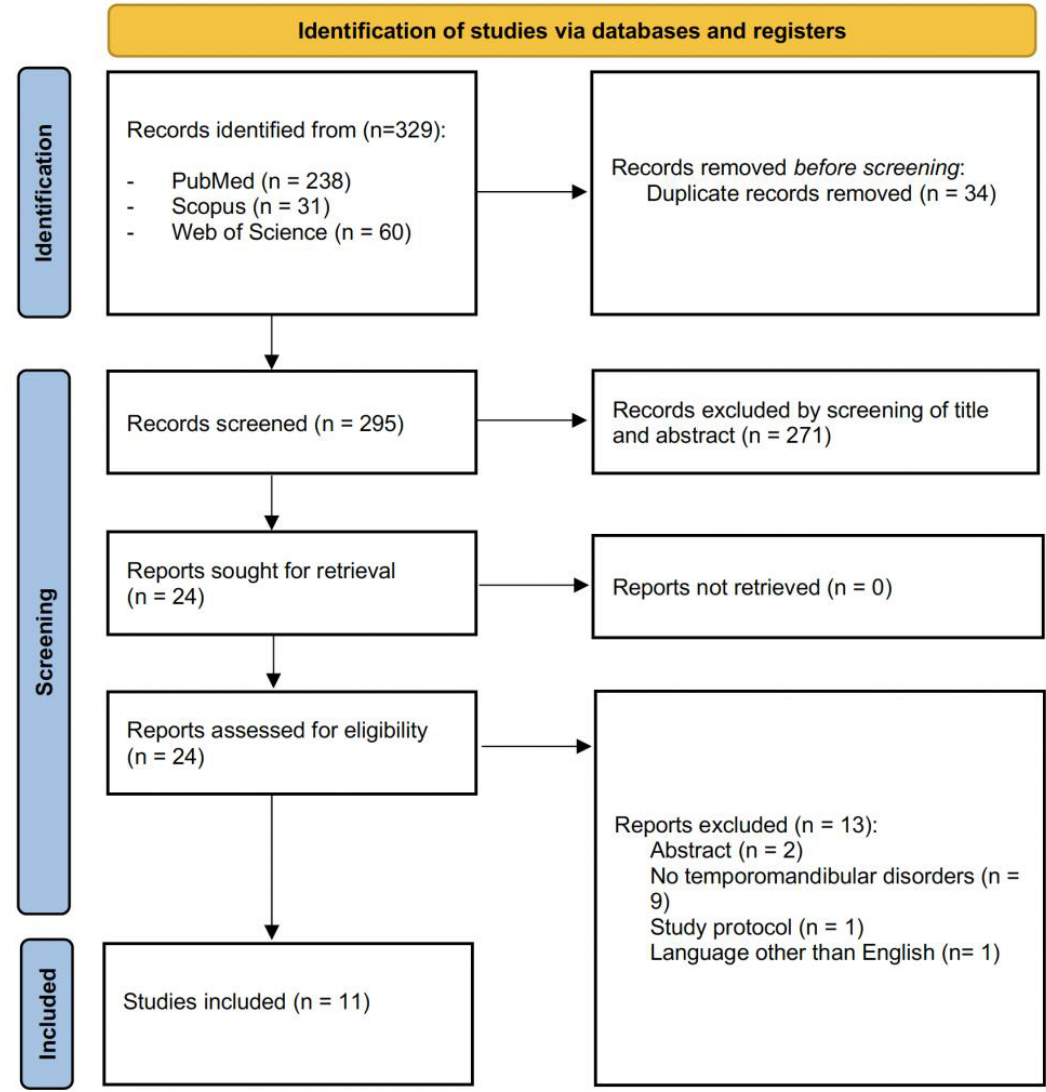
Figure 1. PRISMA 2020 flow diagram.